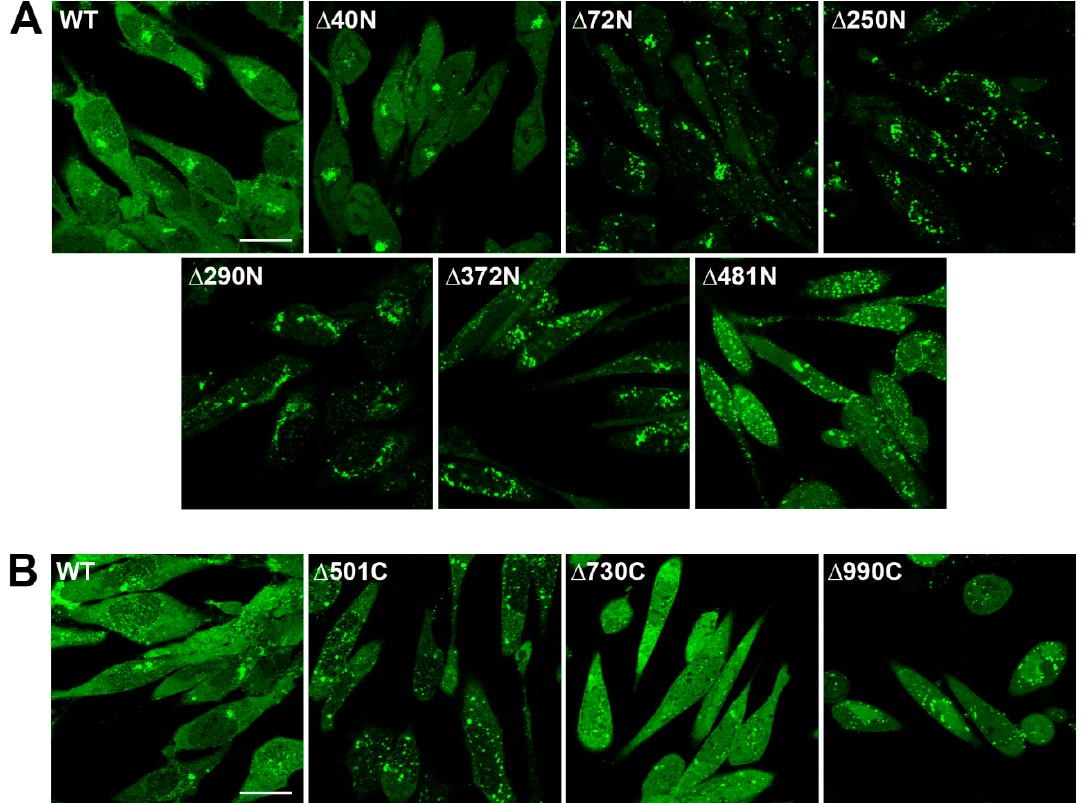
Figure 4. Both amino and carboxyl terminal truncations affect pUL37–EGFP trafficking. RPE-1 cell monolayers in chamber slides were infected with wild-type and each UL37–EGFP mutant virus (excluding Δ 250C) at an MOI of 10 PFU/cell and analyzed by confocal microscopy 12 h post-infection. Wild-type pUL37–EGFP trafficked to the Golgi complex, as evidenced by the juxtanuclear localization and previous data from Desai et al. [35]. ( A ) N-terminal truncations of greater than 40 amino acids resulted in the dispersal of pUL37–EGFP localization to a more perinuclear localization. This was also seen with the functional Δ 481N mutation. ( B ) C-terminal truncations all abolish the juxtanuclear localization pattern and they display different cellular localization, as judged by the fluorescence observed. Scale bar = 25 µm.